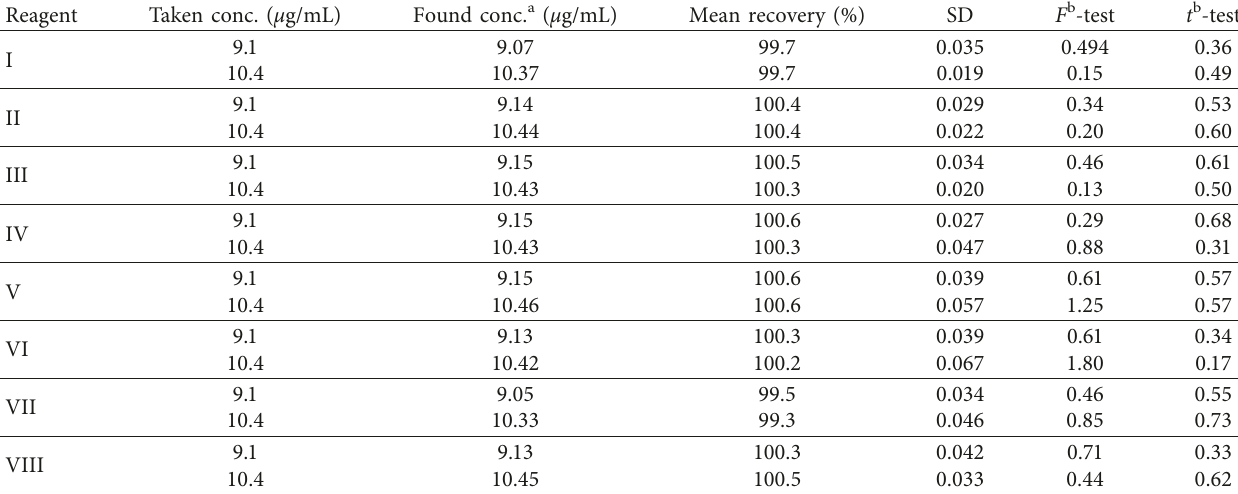
Table 4: Determination of diaveridine in pure preparation.